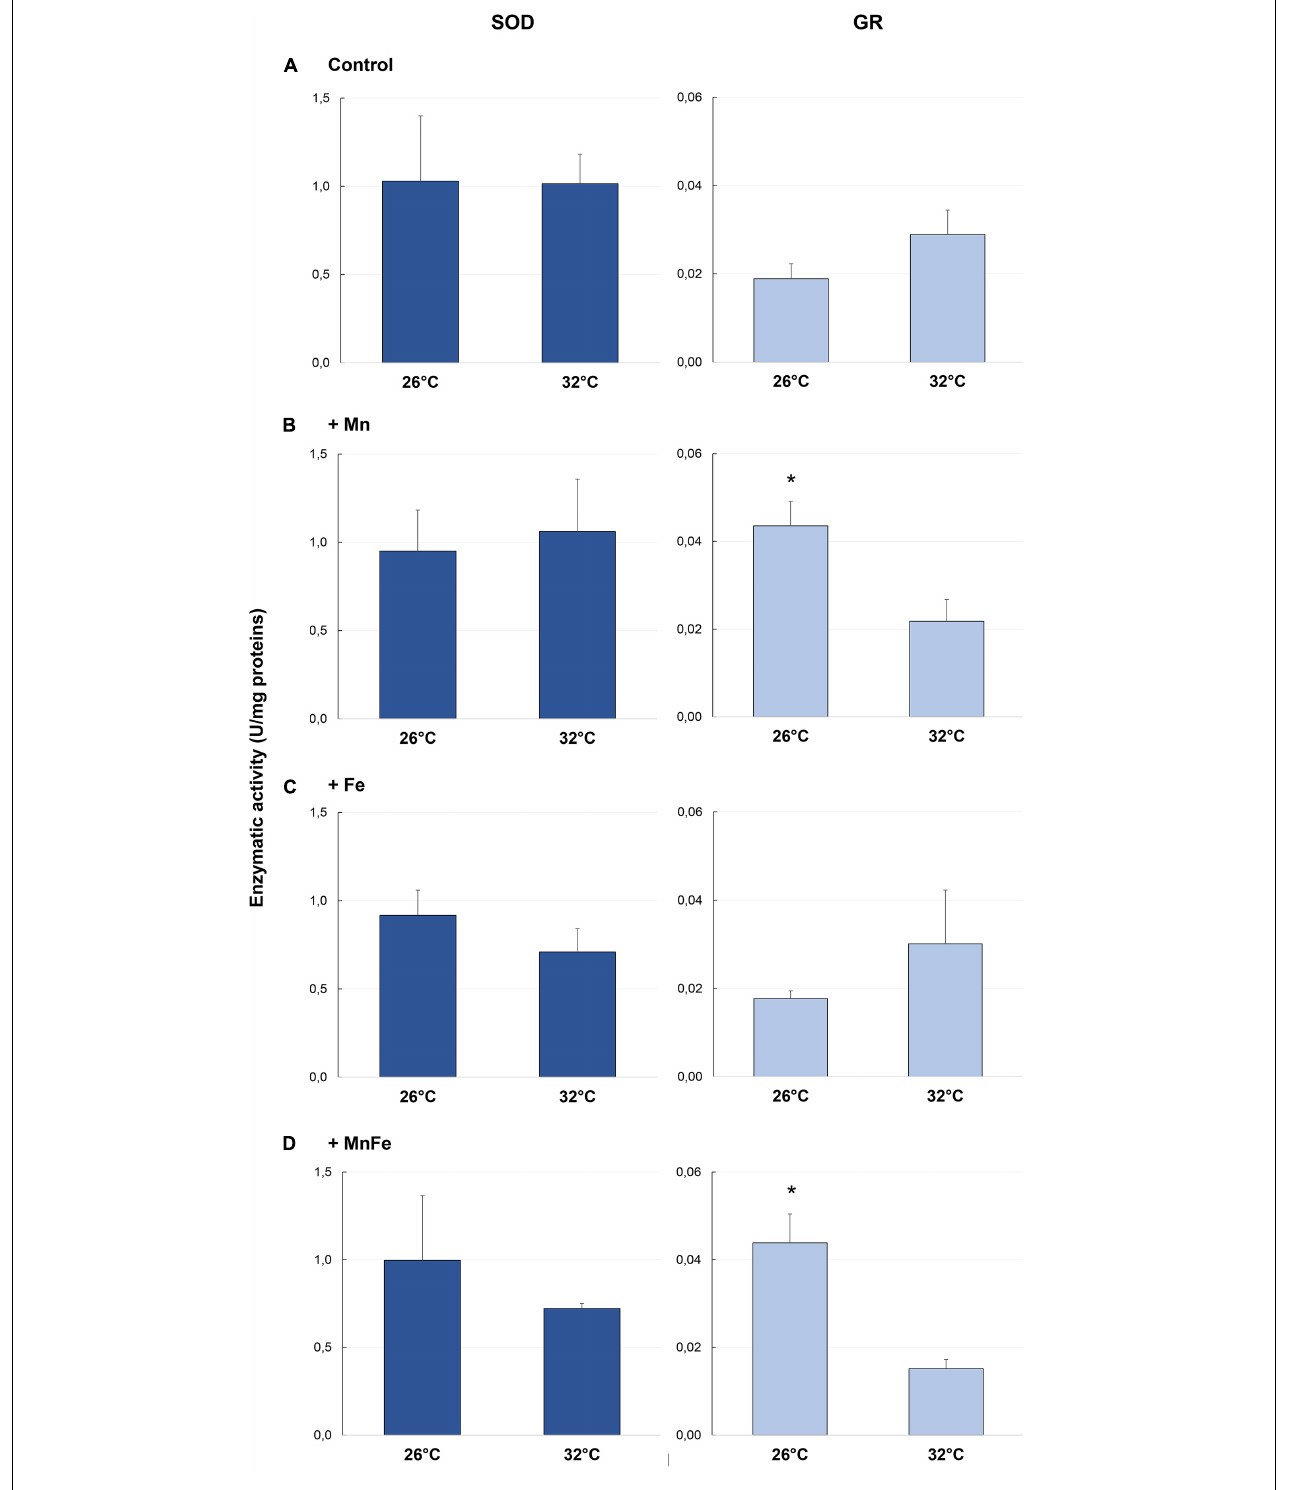
FIGURE 2 | Enzymatic activity of SOD and GR detected in samples of S. pistillata exposed to the different metal treatments ( A : Control; B : +Mn; C : +Fe; D : +MnFe) after 6 weeks at 26 ◦ C or 3 weeks at 32 ◦ C. The values related to the metal concentrations for each treatment are reported in section “Materials and Methods.” Data are expressed as units (U) of enzyme per mg of proteins and as mean ± SEM ( n = 4, for both SOD and GR). For each biomarker, asterisks indicate significant differences between corals maintained at 26 and 32 ◦ C under different treatments and, within each treatment, between corals maintained at 26 and 32 ◦ C.